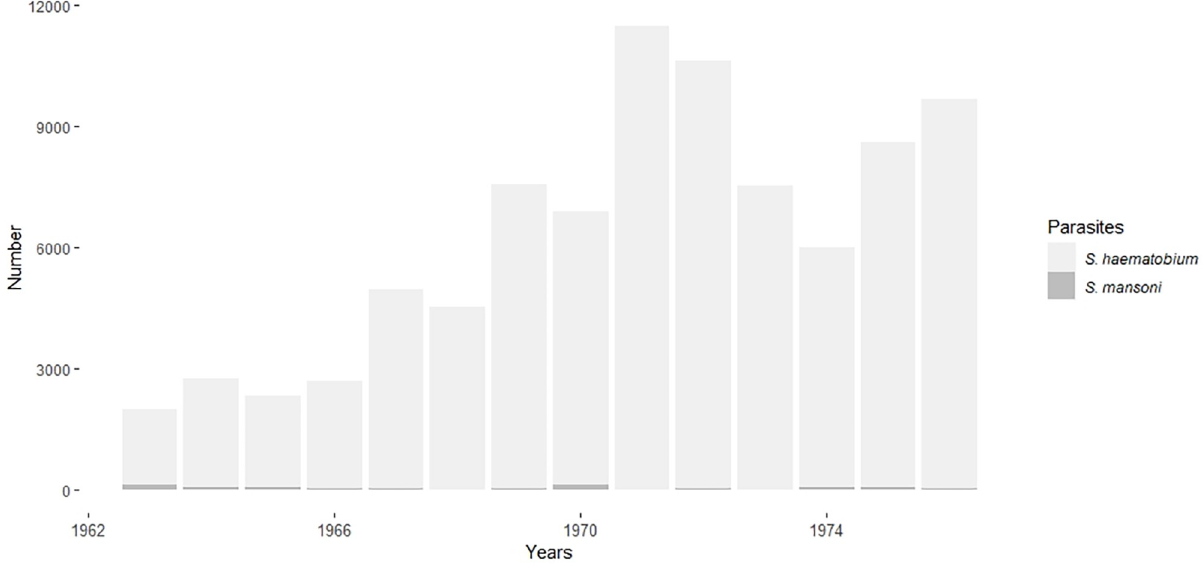
Fig 8. Distribution of schistosomiasis cases reported over the years. The number of urogenital and intestinal schistosomiasis cases reported in a retrospective epidemiological study conducted between 1963 and 1976 [102].